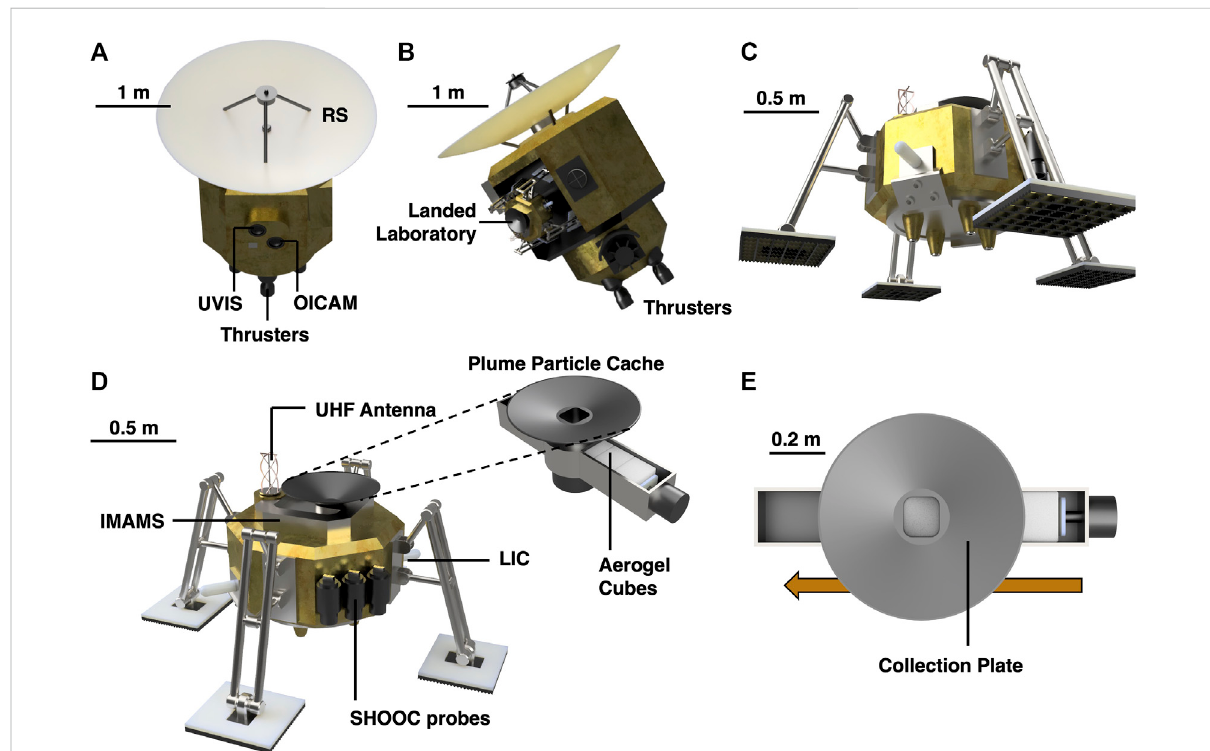
FIGURE 6 Artist ’ srenditionoftheETNAspacecraft. (A) LateralviewoftheorbiterwheretheUVIS,OICAM,andRSinstrumentsarevisible. (B) Lateralviewof the orbiter where the lander attached is visible. (C) A view of the ETNA landed laboratory, highlighting the lander feet design, showing the wide surfaceareasandteeth. (D) ViewofthelanderstructuraldesignshowstheIMAMSpackage,UHFantenna,andPlumeParticleCacheall fi xedontopof the lander, as well as the LIC and deployable SHOOC probes attached to the lander sides. Dashed lines show close-up view of the Particle Cache, including the aerogel cubes. (E) Top-down view of the sampling collection plate on the Plume Particle Cache. Aerogel cubes are exposed oneatatime andpushedthroughto thespectrometer. For scale,RSdish in (A,B) is3 m across andparticle cache in (C – E) is 40 cmacross. Notethat the fuel tanks are not included in this artist ’ s rendition but are considered to be spherical at the present design stage (radii = 0.41, 0.56, and 0.71 m; Section